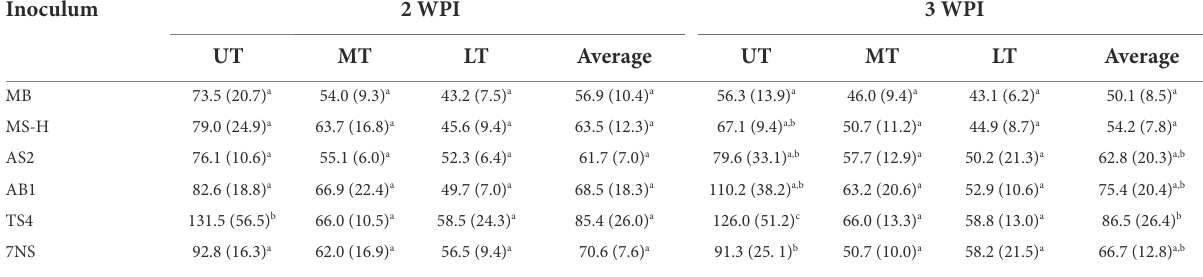
TABLE 5 Mucosal thicknesses of upper trachea (UT), middle trachea (MT), and lower trachea (LT) collected 2- and 3-week after inoculation of chickens with various strains or reisolates of MS following intratracheal inoculation of a virulent strain of IBV.